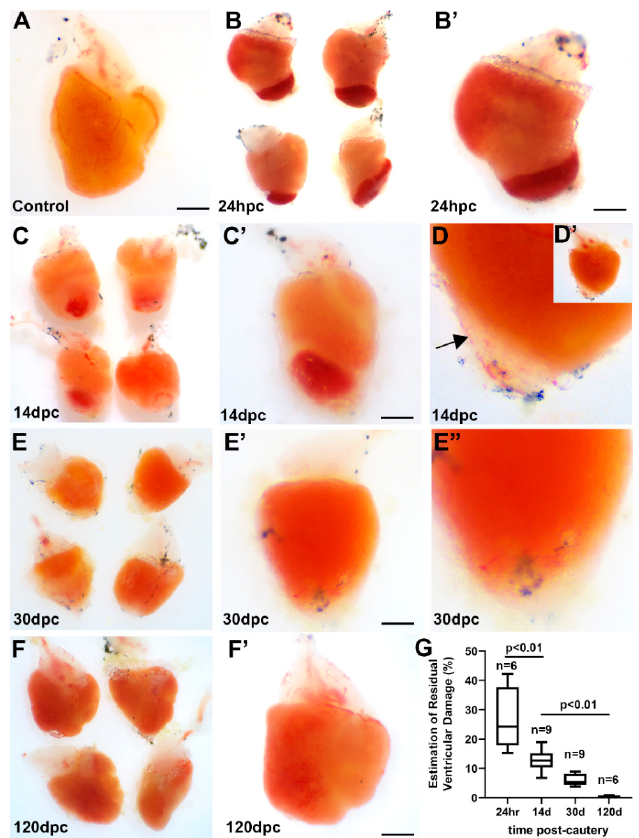
Figure 1. Gross characteristics of the injured and repairing zebrafish heart. Image of a non-injured excised adult zebrafish heart ( A ), and examples of four hearts 24 h post-cautery (hpc) showing a distinct area of injury ( B ). One of the hearts in panel B at higher magnification ( B’ ) shows a clear demarcation between the clotted and normal-appearing tissue. Four hearts display the presence of ventricular clot at 14 days post-cautery (dpc) ( C ) as well as a region of white translucent tissue at the apical region surrounding the clot. One of the hearts at 14 dpc ( C’ ) contains an achromatic area surrounding the clot. The ventricle of a 14 dpc heart at a lower and a higher magnification ( D , D’ ) contains a blood vessel (arrow) coursing over the clear repairing area. A clot is no longer observed within hearts at 30 dpc, and the repairing area is markedly decreased ( E , E’ , E” ). Injured hearts at 120 dpc ( F ) appear grossly similar to the uninjured heart in ( A ), except for occasional indentation in the apical area ( F’ ). Quantitation ( G ) shows a progressive and significant decrease in the injured area.